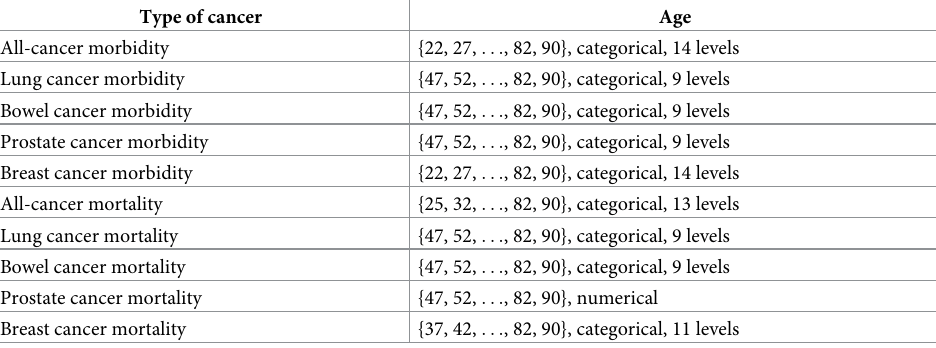
Table 1. Structure and levels of age covariate in the best fitted models for different types of